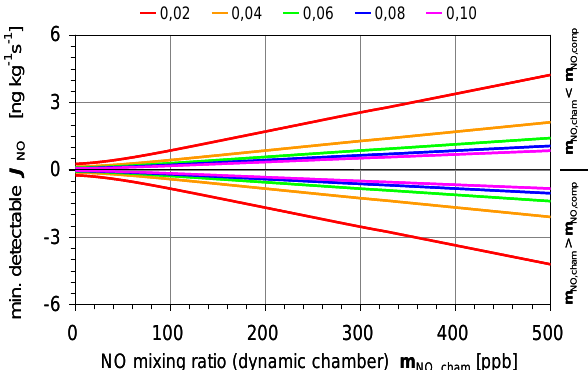
Figure 9. Minimum detectable net NO release rate as function of the NO mixing ratio in the soil chamber’s headspace. Data have been calculated for LOD NO = 0.15 ppb on the basis of the NOx-analyzer’s precision (s. Fig. 8). Color code indicates different values of dry mass of the enclosed soil ( m soil,dry , in kg).